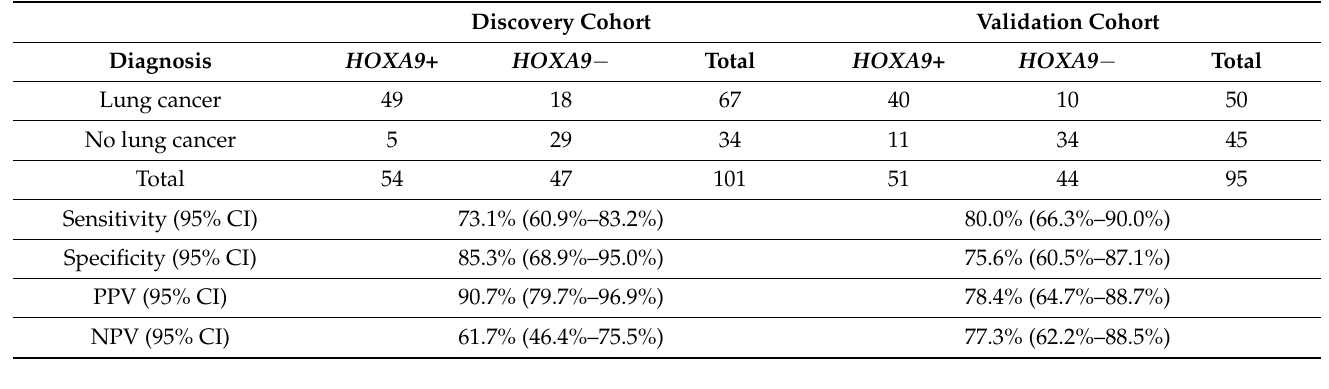
Table 3. Methylated HOXA9 as a diagnostic biomarker for lung cancer reported for the Discovery and Validation cohorts, respectively. HOXA9 + indicates detectable methylated HOXA9 ( ≥ 0.13%) in the bronchial lavage sample and hence a positive test. HOXA9 - indicates a negative test with no detectable methylated HOXA9 (<0.13%). Sensitivity, specificity, positive predictive value (PPV) and negative predictive value (NPV) are reported with 95% confidence intervals